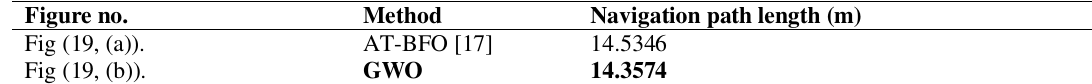
Table 4 , Results Comparison with Reference [17]. Figure no. Method Navigation path length (m) Fig (19, (a)). AT-BFO [17] Fig (19, (b)).